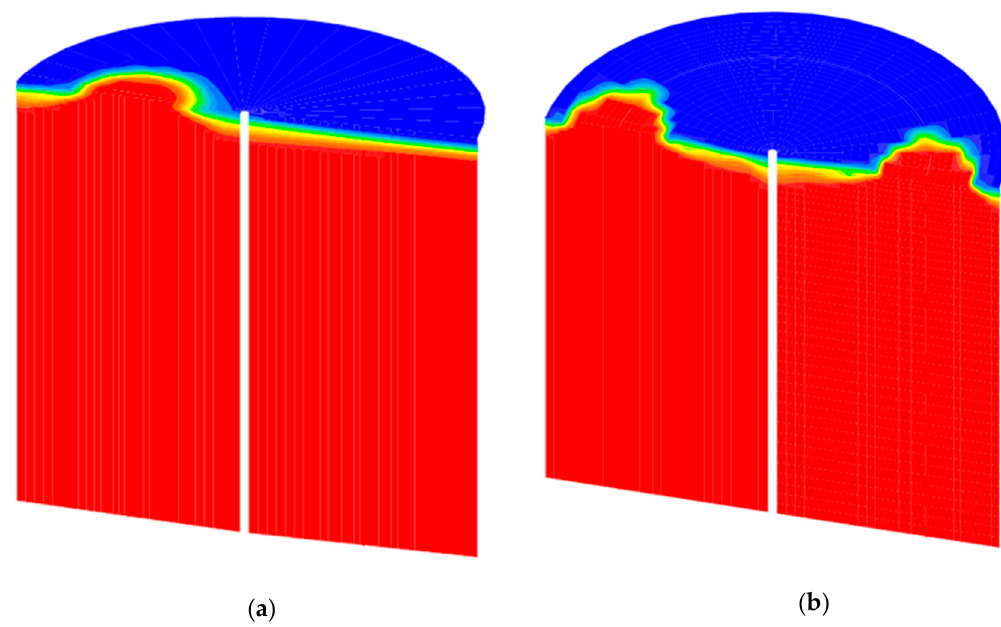
Figure 4. Steel–slag distribution (Steel, red phase; blue, slag phase) according to the mathematical model predictions considering the two cases in this study ( a ) single plug gas injection with nozzle at 1/3 R and ( b ) dual plug gas injection with nozzles at 2/3 R, observing a small numerical diffusion due to the use of a finer grid in the said interface, improving the degree of precision.